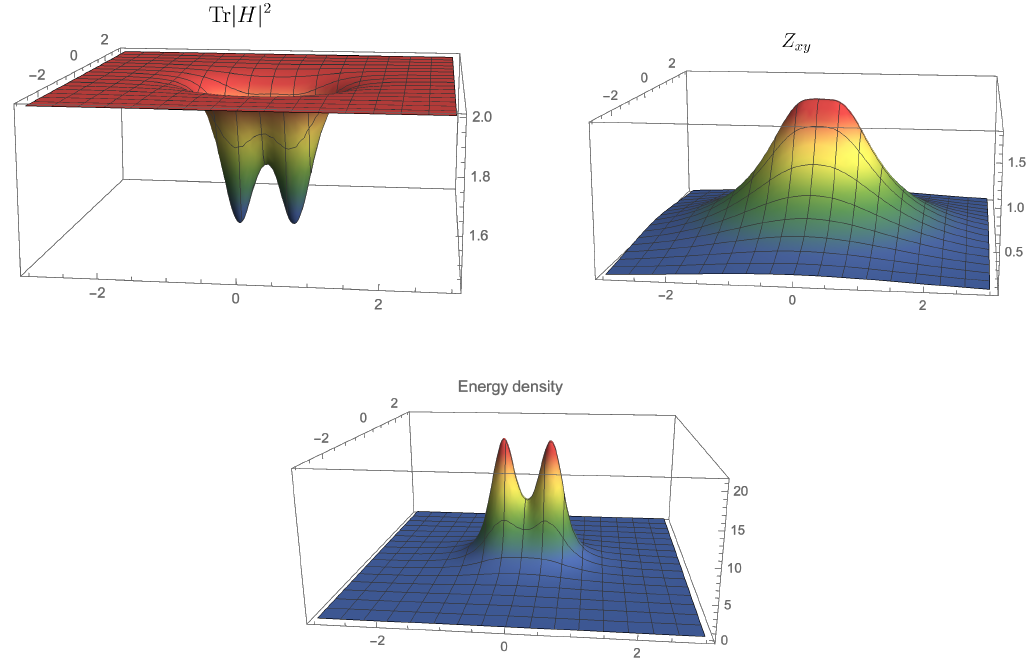
Figure 8 . Plots of the vortex molecule solution in the U(1) a -broken case. Upper-left, upper-right, and lower panels show the Higgs field Tr | H | 2 , Z -flux Z xy , and the energy density, respectively, in the xy plane. Although the U(1) a symmetry is explicitly broken, the vortex molecule is still stable. The parameters are taken as the text (eq. (6.3)). The length unit is taken so that v (= 123 GeV) = 1